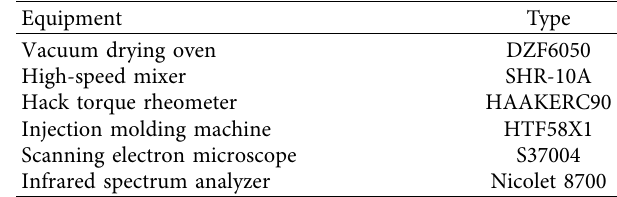
Table 3: Preparation equipment.